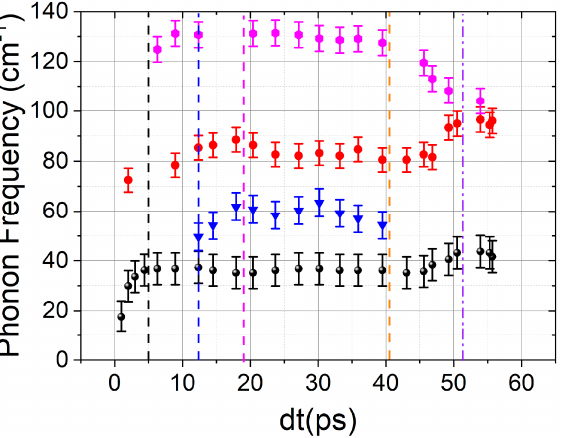
Figure 5. Dynamics of coherent phonon frequencies in silicon under the impact of a mid-IR femtosecond laser pulse.